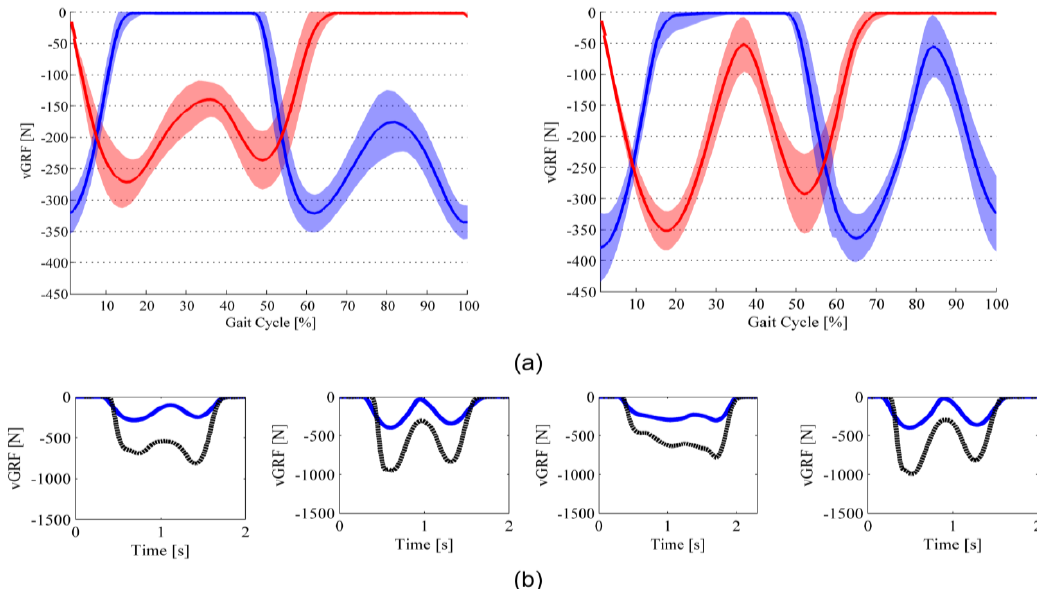
Figure 9. profiles of Subject #2. Red line is the left foot; blue line is the right foot. ( a ) Average curve during slow- (on the left panel) and normal- (on the right panel) speed ground-level walking; ( b ) Comparison between the profile measured through the sensorized insole (solid blue line) and the force platform (dotted black line) in four different steps.